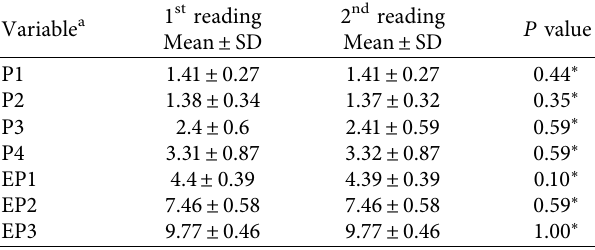
Table 1: Evaluation of intraobserver reliability for variables (mm). Variable